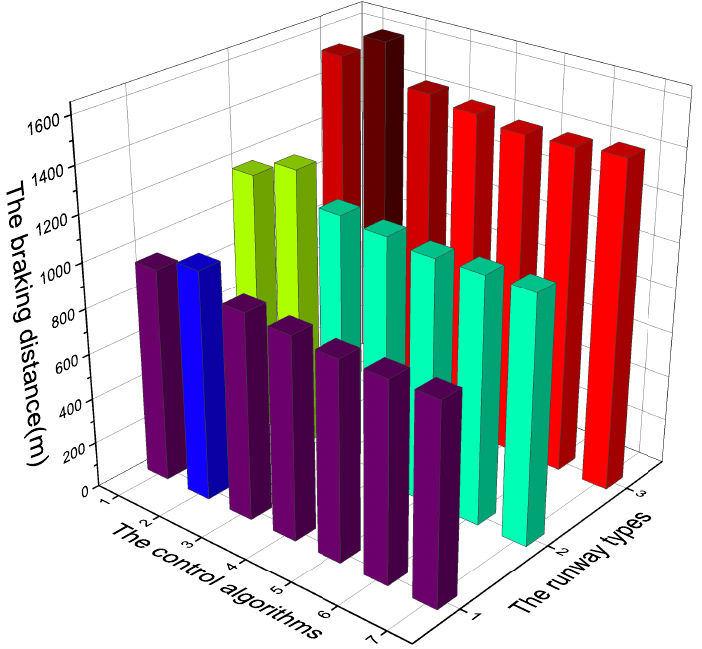
4 = BSMC, 5 = NSMC, 6 = NSMCF, and 7 = NSMCR. For those numbers in the runway type axis, 1 = dry runway, 2 = wet runway, and 3 = icy runway. From Figure 12, it can Figure 11. Simulation results of event trigger percentage. Figure 11. Simulation results of event trigger percentage.